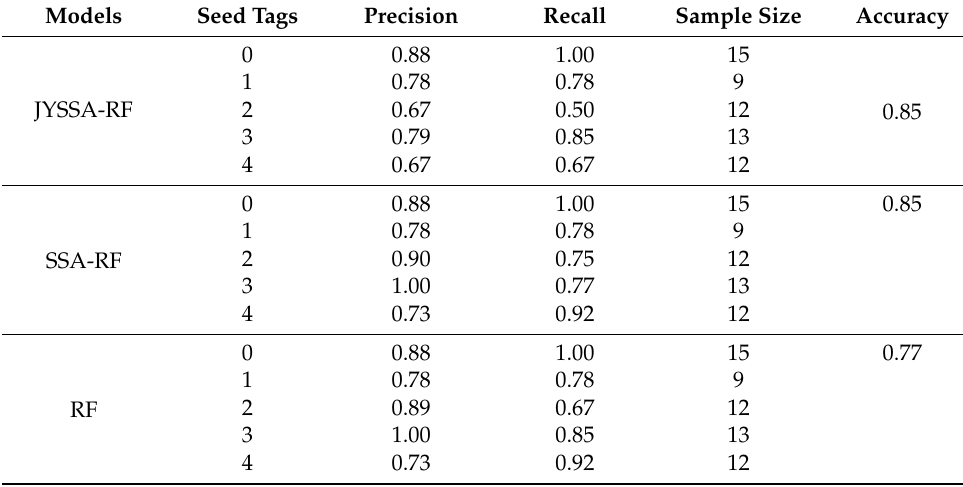
Table 4. Results of the three model test sets in the 462 bands.